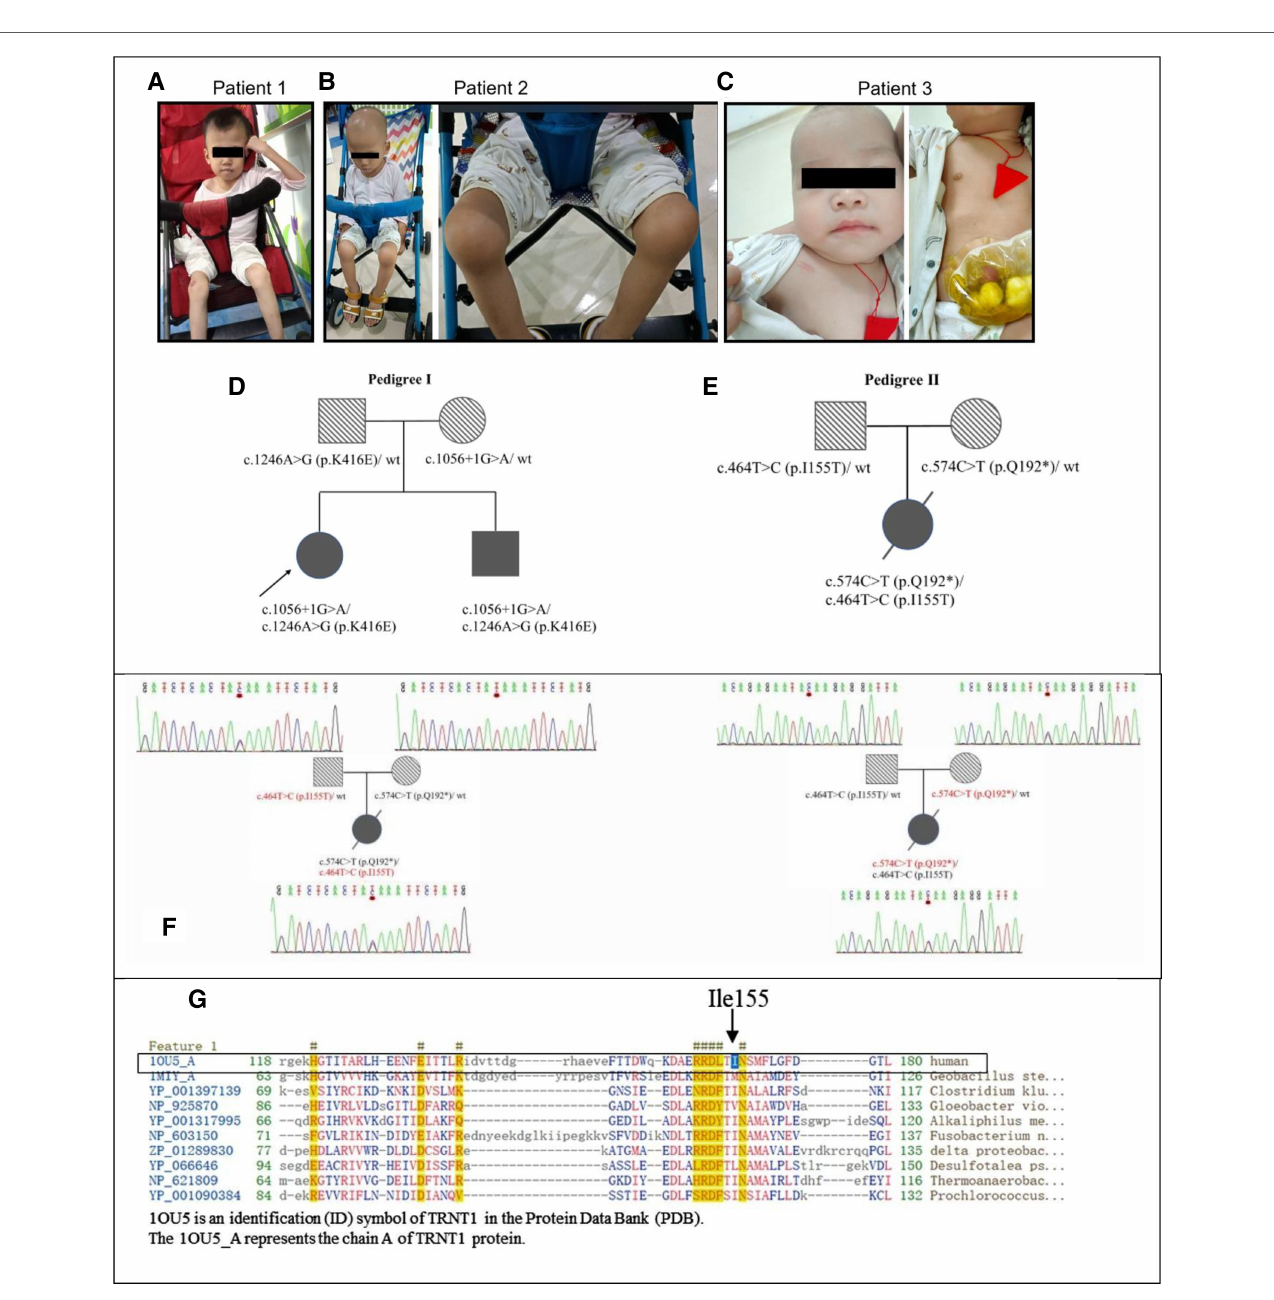
FIGURE 1 The genetic and clinical characteristics of SIFD patients. ( A ) Patient 1 at the age of 14 years presented with hypotrophic muscle and arthritis. ( B ). Patient 2 at the age of 7 years presented with hypotrophic muscle and arthritis. ( C) Patient 3 at the age of 11 months. ( D) The pedigree of siblings in the fi rst family with patient 1 and patient 2. ( E) The pedigree of patient 3. ( F) The Sanger sequencing chromatograms of TRNT1 gene compound heterozygous variations of the family with patient 3. The mutation c.574C>T (p.Q192*) inherited from her mother and c.464T>C (p.I155T) inherited from her father. ( G) The conserved amino acid sequence in protein TRNT1. The black arrow points a conservative amino acid (Ile155) of protein TRNT1 in human. SIFD, sideroblastic anemia with B-cell immunode fi ciency, periodic fevers, and developmental